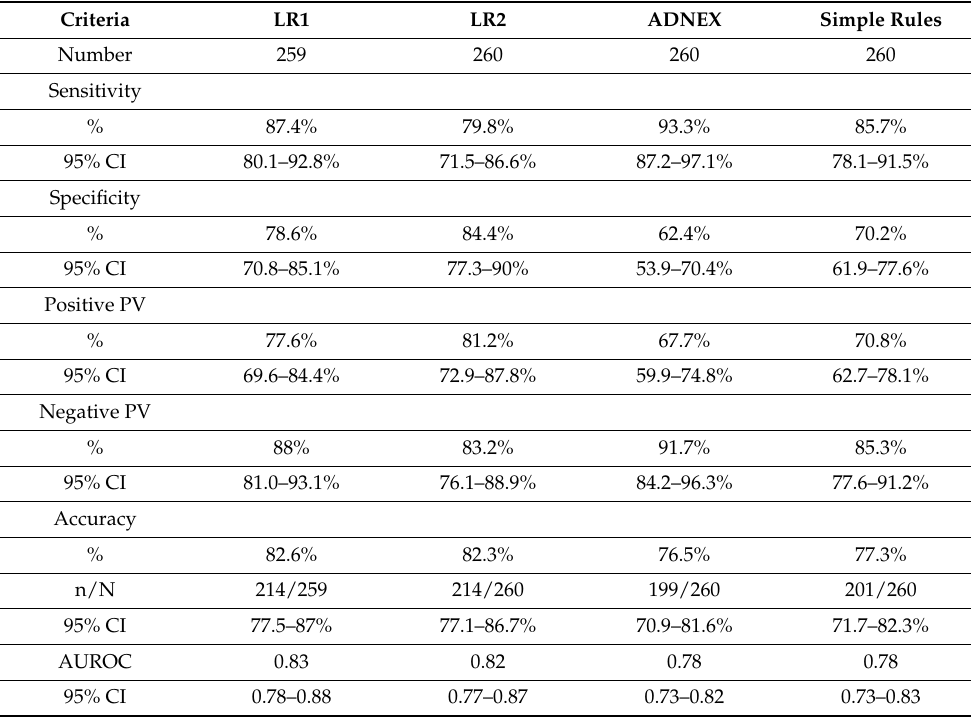
Table 3. Performance of imaging in the identification of ovarian